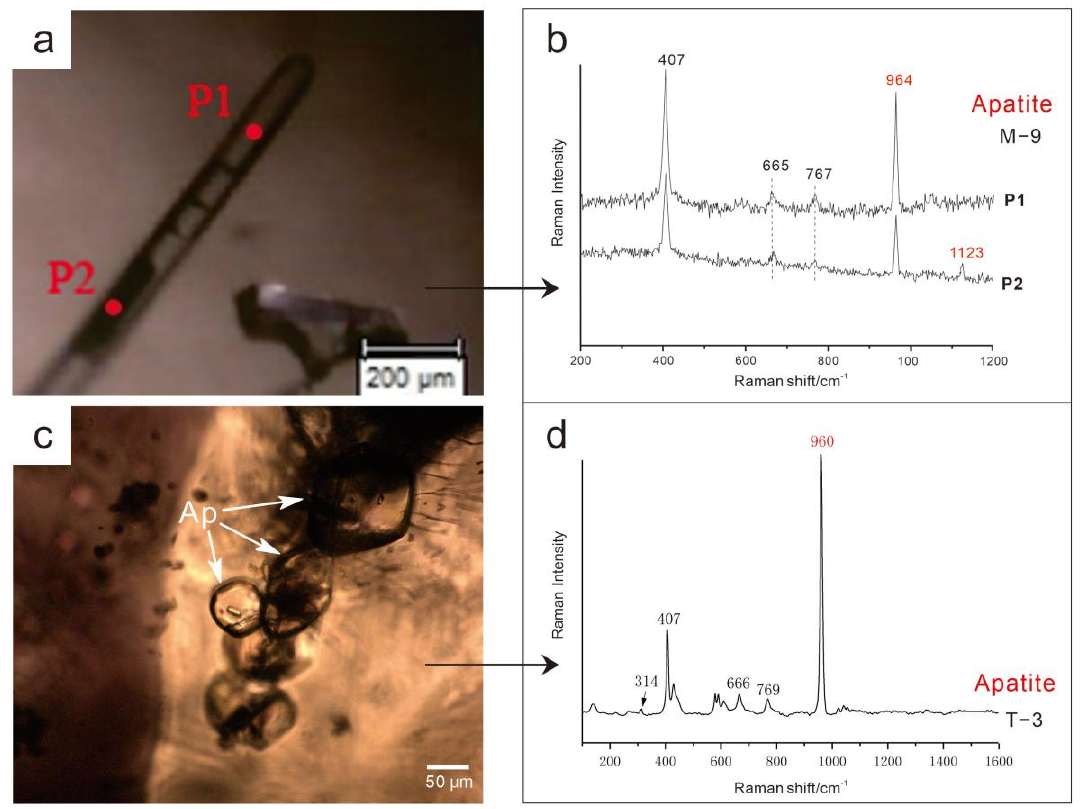
Figure 7. ( a ) Apatite inclusions in Myanmarese spinel (M − 9) and ( b ) their (M − 9) Raman spectra. ( c ) Apatite inclusions in Tajikistani spinel (T − 3) and ( d ) their (T − 3) Raman spectra. The colorless crystal inclusions in T-3 were divided into large and small sizes (Figure 7c): the larger ones (80 µ m in diameter) were generally rounded in shape, while the smaller ones (20 × 5 µ m) were approximately columnar. These inclusions were usually clustered together. Raman spectroscopy of these crystal inclusions showed that the larger, rounded, colorless crystal inclusions were apatite (Figure